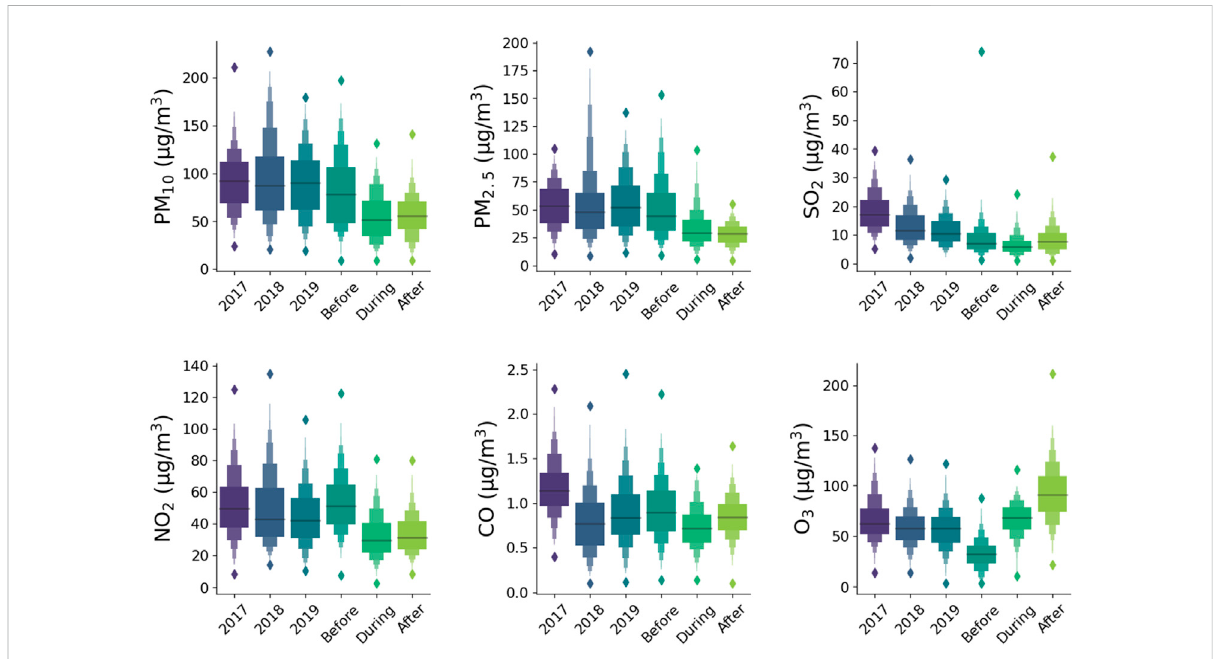
FIGURE 2 Daily average concentrations of PM 10 , PM 2.5 , SO 2 , NO 2 , CO, and O 3 during the all-study periods in